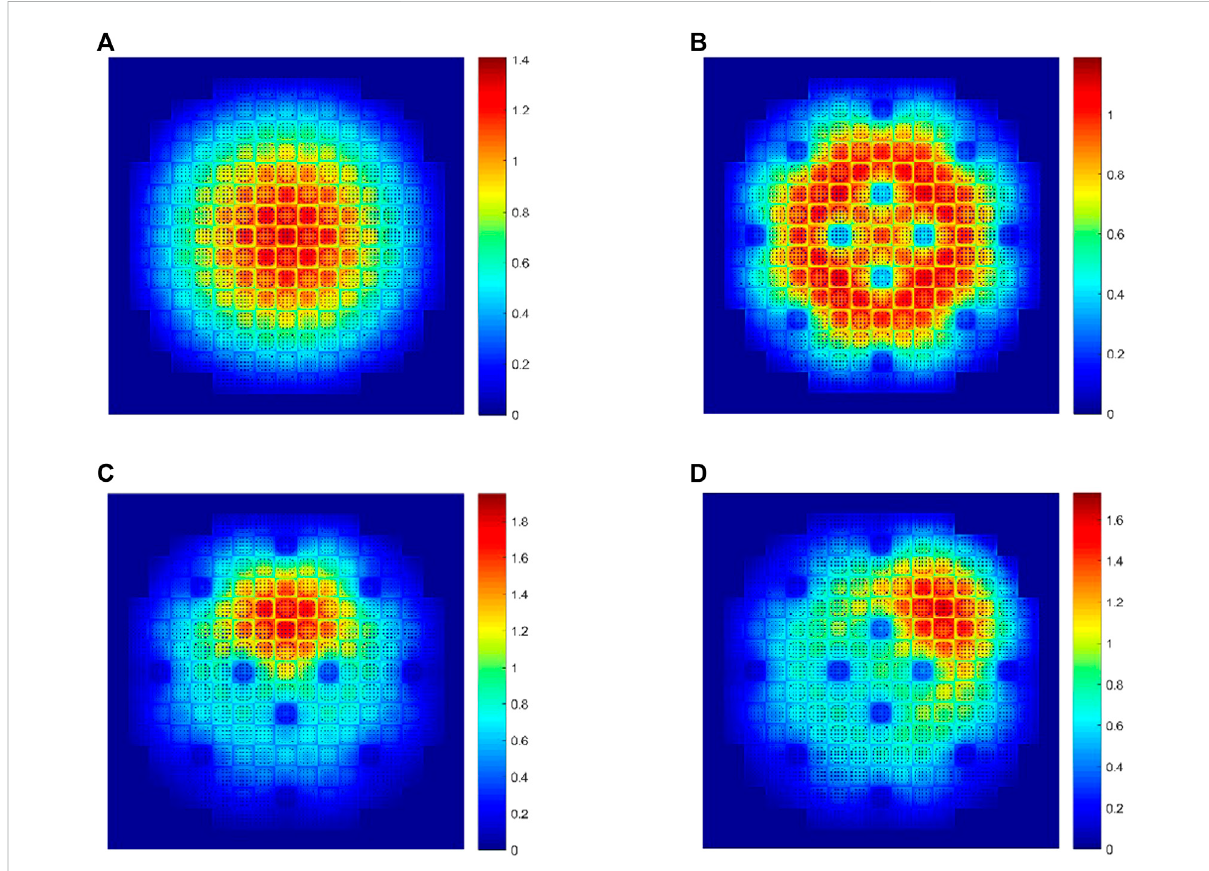
FIGURE 11 Power density distributionusing thecomePSn_JFNKcodefor 2-Dfull-coreMOX/UOXpin-by-pinmodels: (A) model A, (B) modelB, (C) model C and (D) model